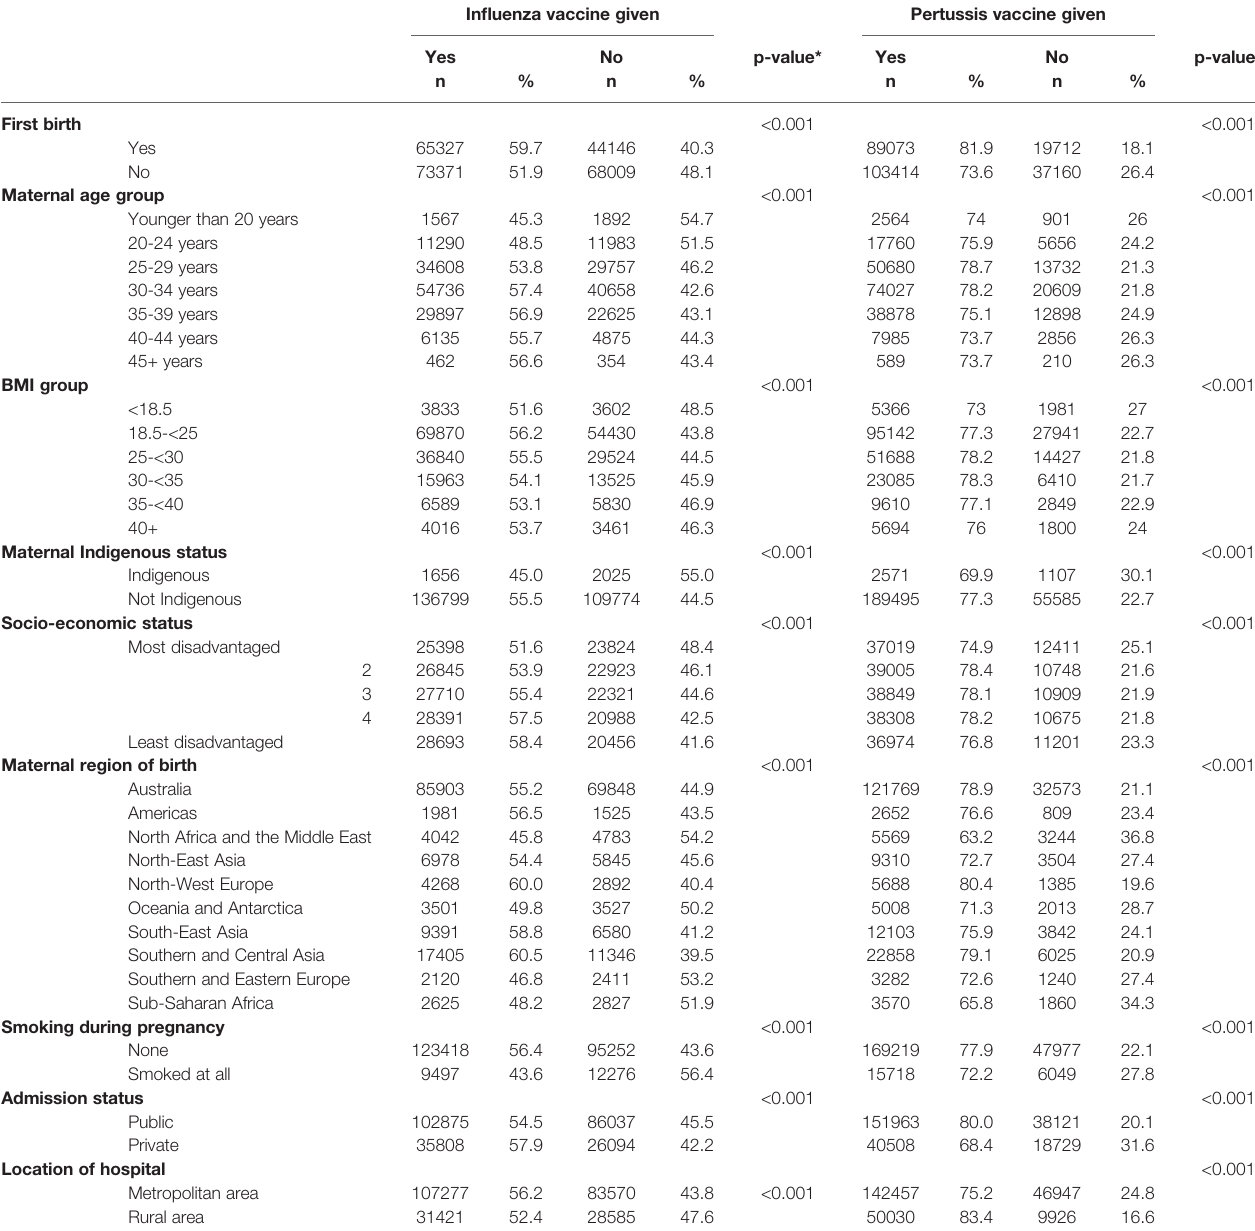
*Chi square for vaccinated vs not